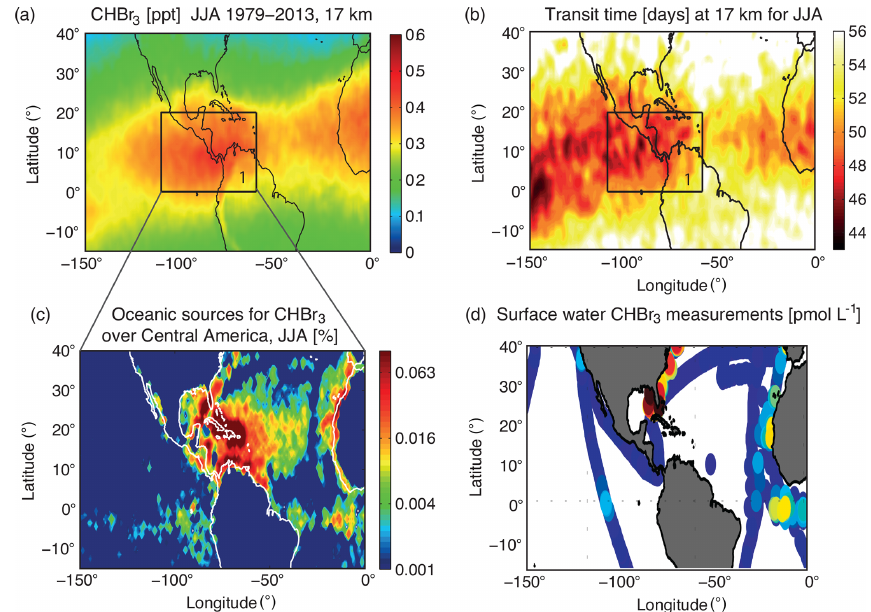
Figure 2. Modelled distribution of CHBr 3 at 17km for JJA, 1979–2013 (a) , transit time of air masses from the ocean surface to the TTL (b) , oceanic source regions for CHBr 3 (c) , and measurements of oceanic CHBr 3 concentrations from the HalOcAt database used for Ziska et al. (2013) (d) . The oceanic source regions in (c) are colour coded according to their contribution (% per 1 ◦ × 1 ◦ grid box) to the amount of CHBr 3 at 17km in the black box over Central America (highlighted in a and b